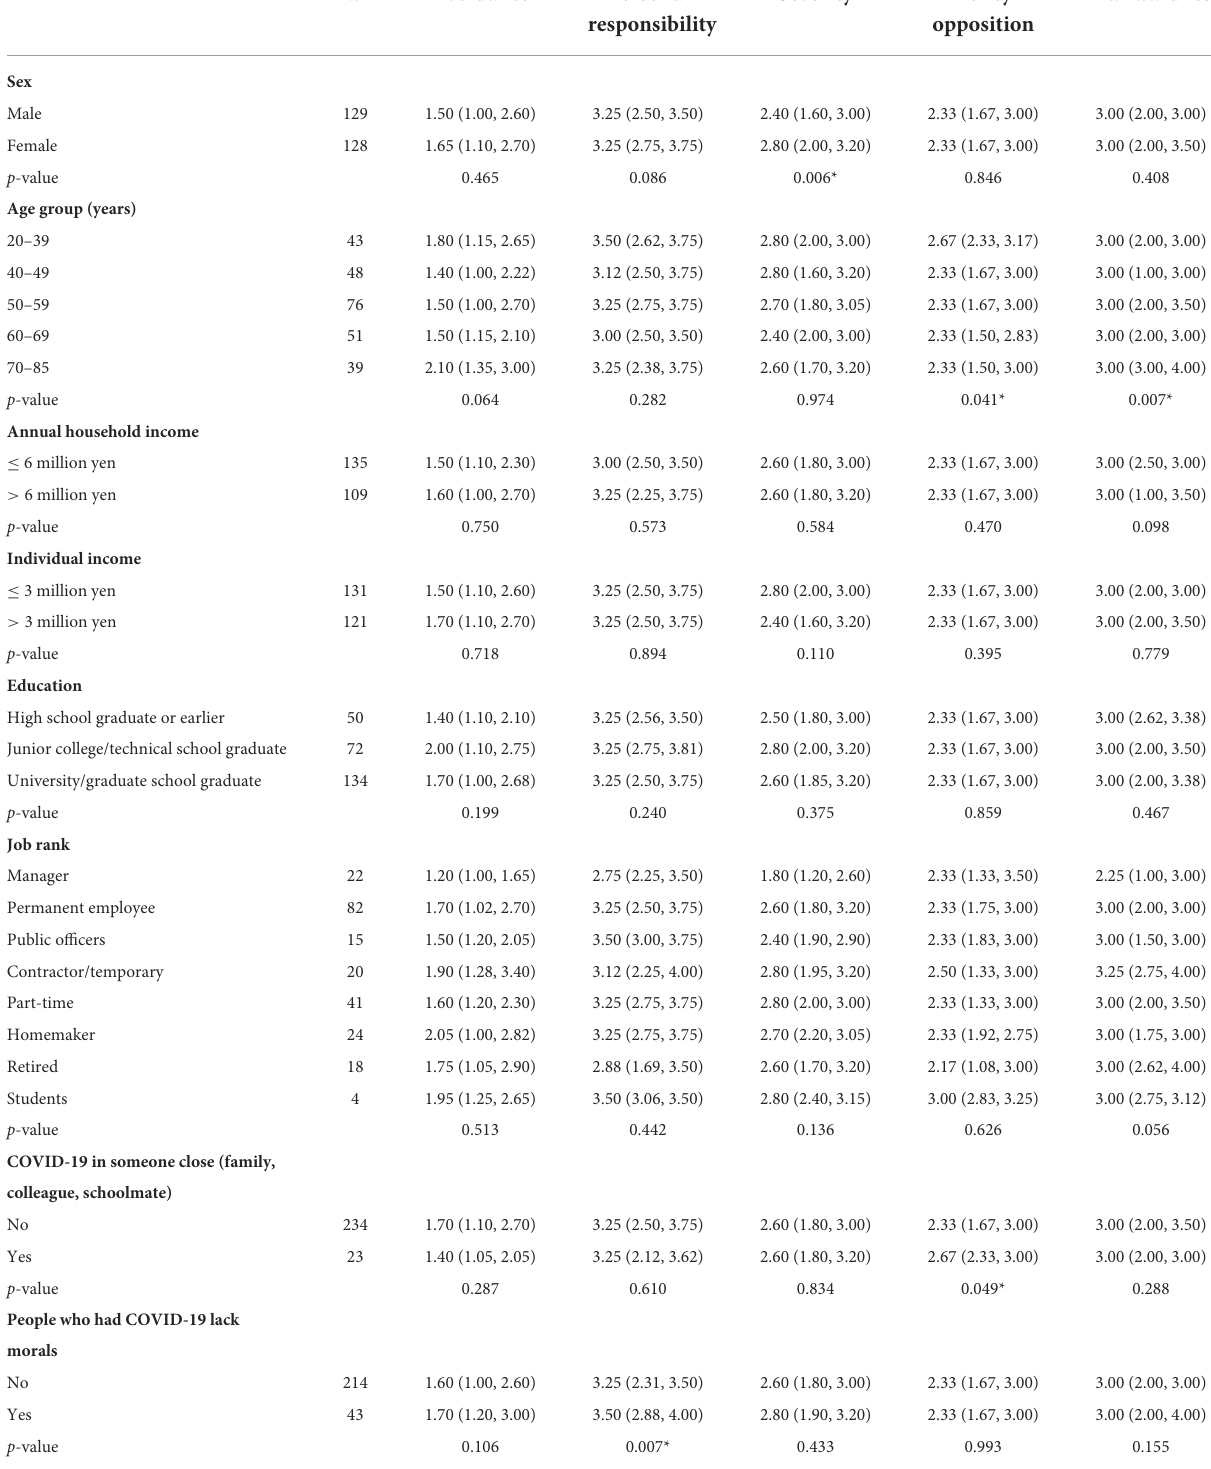
TABLE 4 COVID-19 stigma scale scores for each factor according to each characteristic subgroup. n Avoidance Personal Severity Policy responsibility opposition